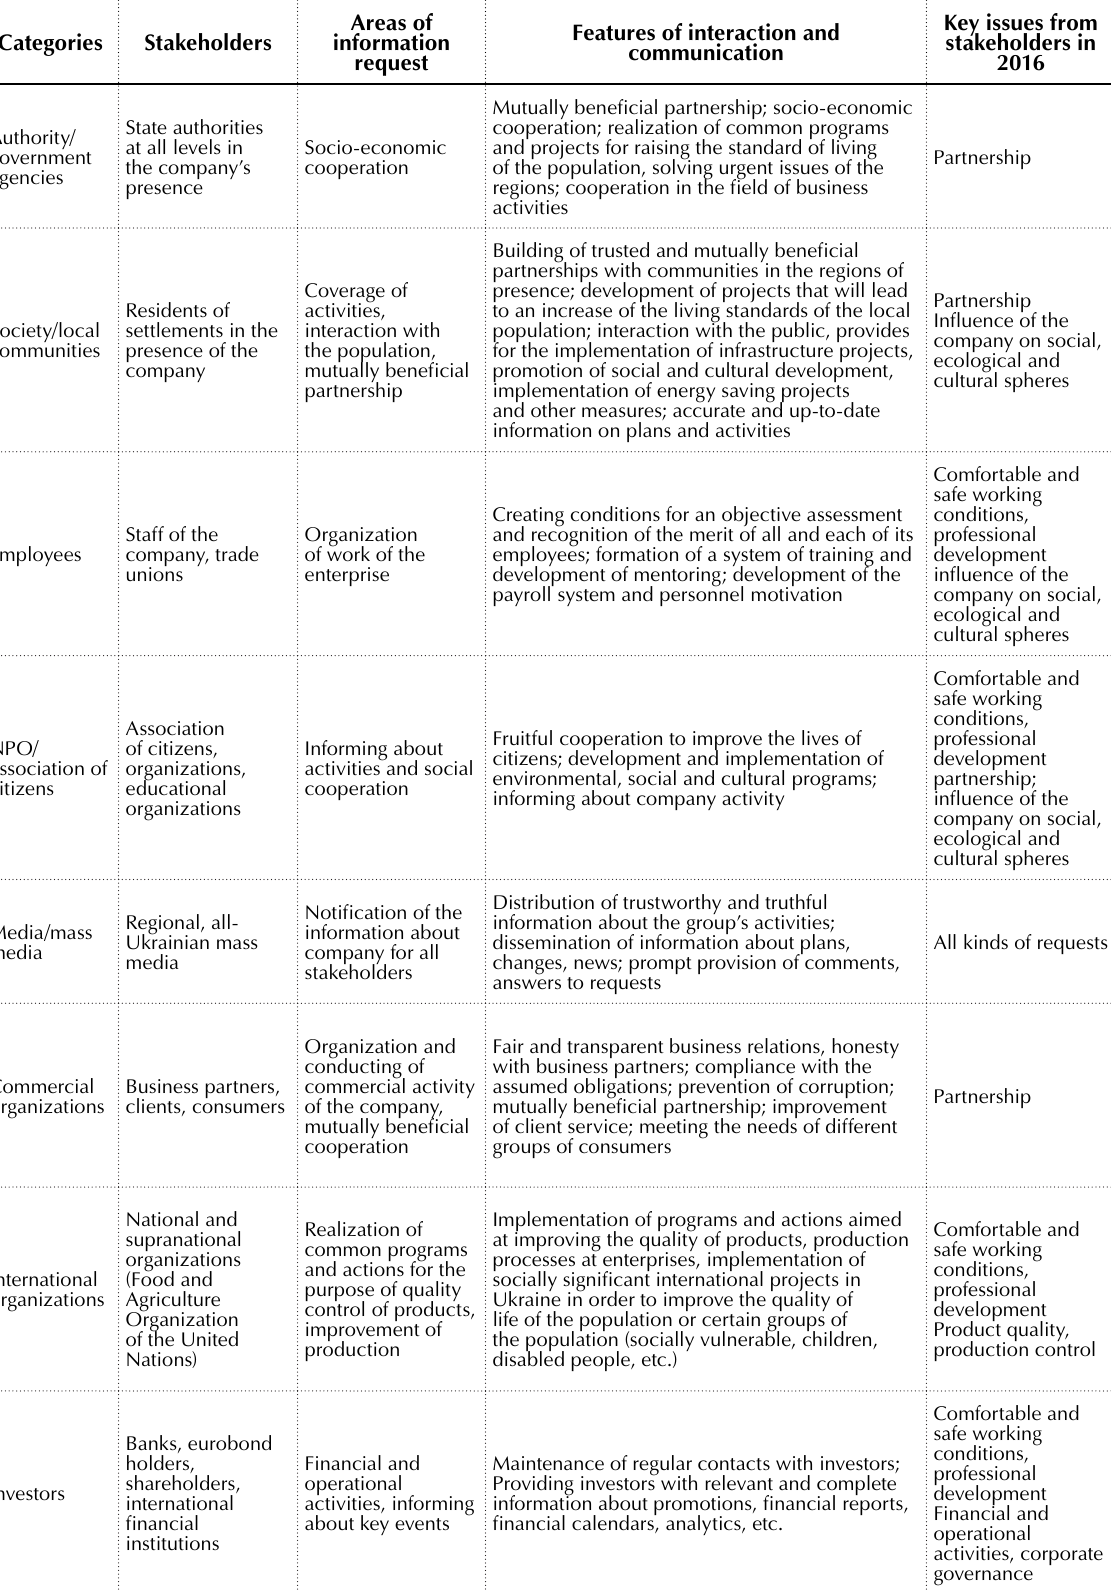
Table 3. Categories of stakeholders and their information requests by the MHP company Source: Supplemented by the authors in accordance with MHP (2016,